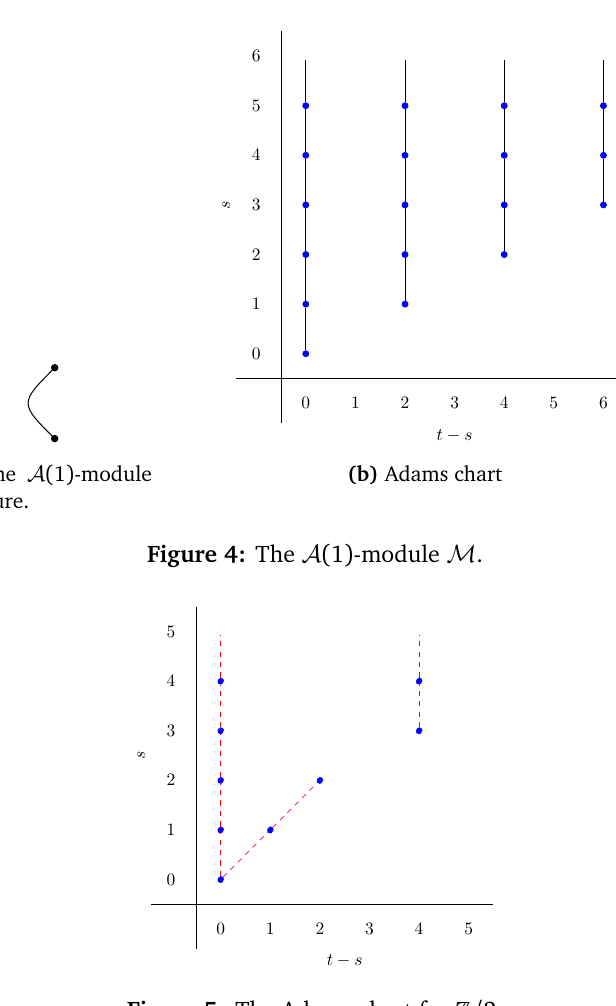
Figure 5: The Adams chart for (cid:90) / 2. Table 1: The spin bordism groups for B (cid:90) / 2 m in degrees d ≤ 6 for m > 1.